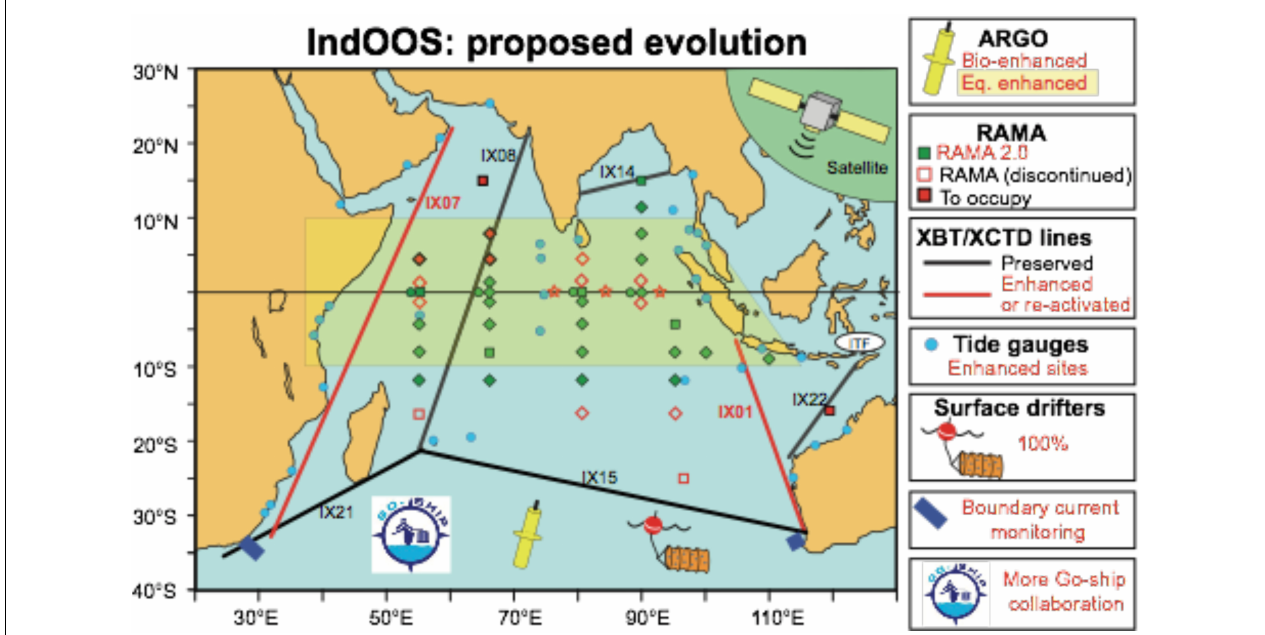
FIGURE 2 | IndOOS original design and current state. The original IndOOS design comprises the RAMA, Argo, XBT/XCTD, surface drifting buoys and tide gauges components.